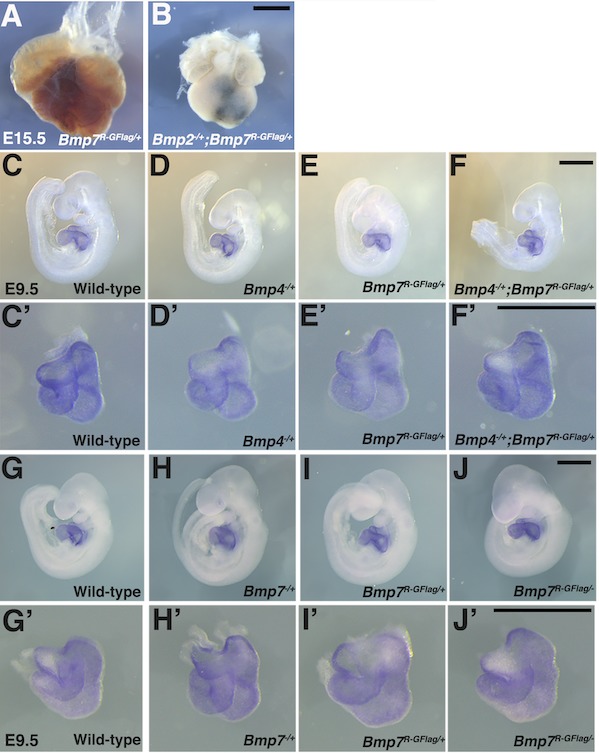
Heart defects are present in Bmp2-/+;Bmp7R-GFlag/+ embryos at E15.5 and are absent in Bmp4-/+;Bmp7R-GFlag/+ and Bmp7R-GFlag/- embryos at E9.5.(A–B) Photograph of heart dissected from Bmp2-/+;Bmp7R-GFlag/+ embryo and Bmp7R-GFlag/+ littermate. (C–J’) Expression of Nkx2.5 was analyzed by whole mount in situ hybridization in littermates generated by intercrossing Bmp4-/+ and Bmp7R-GFlag/+ (C–F’) or Bmp7-/+ and Bmp7R-GFlag/+ mice (G–J’). Photographs of intact embryos at E9.5 (C–J) and photographs of hearts dissected from corresponding embryos (C’–J’) are shown. Scale bars in all panels correspond to 1 mm.